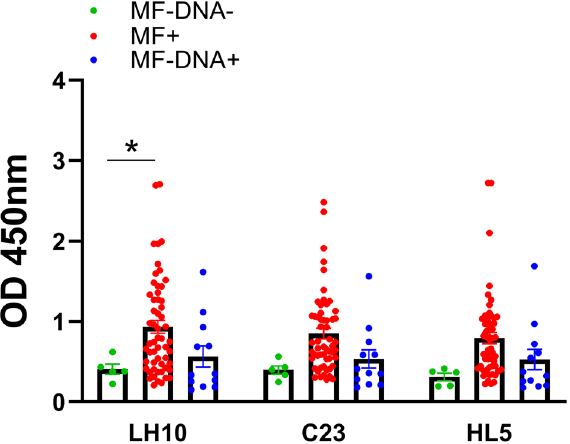
Figure 4. Phage ELISA showed that LH10 clone has the highest diagnostic potential among examined clones. The IgG responses to selected clones was evaluated in microfilaremic (MF +), amicrofilaremic (MF− DNA +) and negative (MF− DNA −) groups of dogs. Plates were coated with 1.46 × 10 11 pfu/well of LH10/C23/HL5 clones in TBS. Plates were blocked with 0.1 M NaHCO 3 , 0.5% BSA and washed three times. Dogs sera were used in 1:800 dilution in blocking buffer. After six washes, secondary anti-dog IgG-HRP antibodies were used